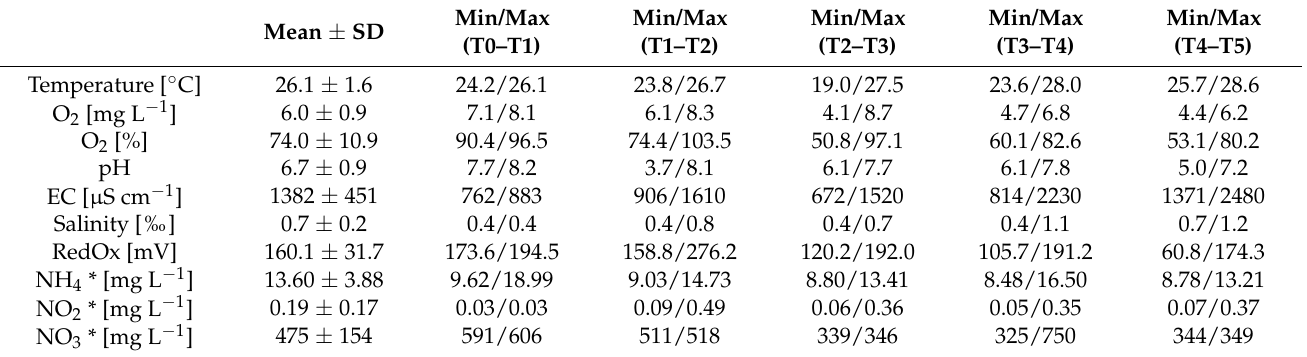
Table 1. Water parameters as mean ± standard deviation (SD) and minimum/maximum values between samplings (T0–T1, T1–T2, etc.). The parameters were measured every day (or weekly